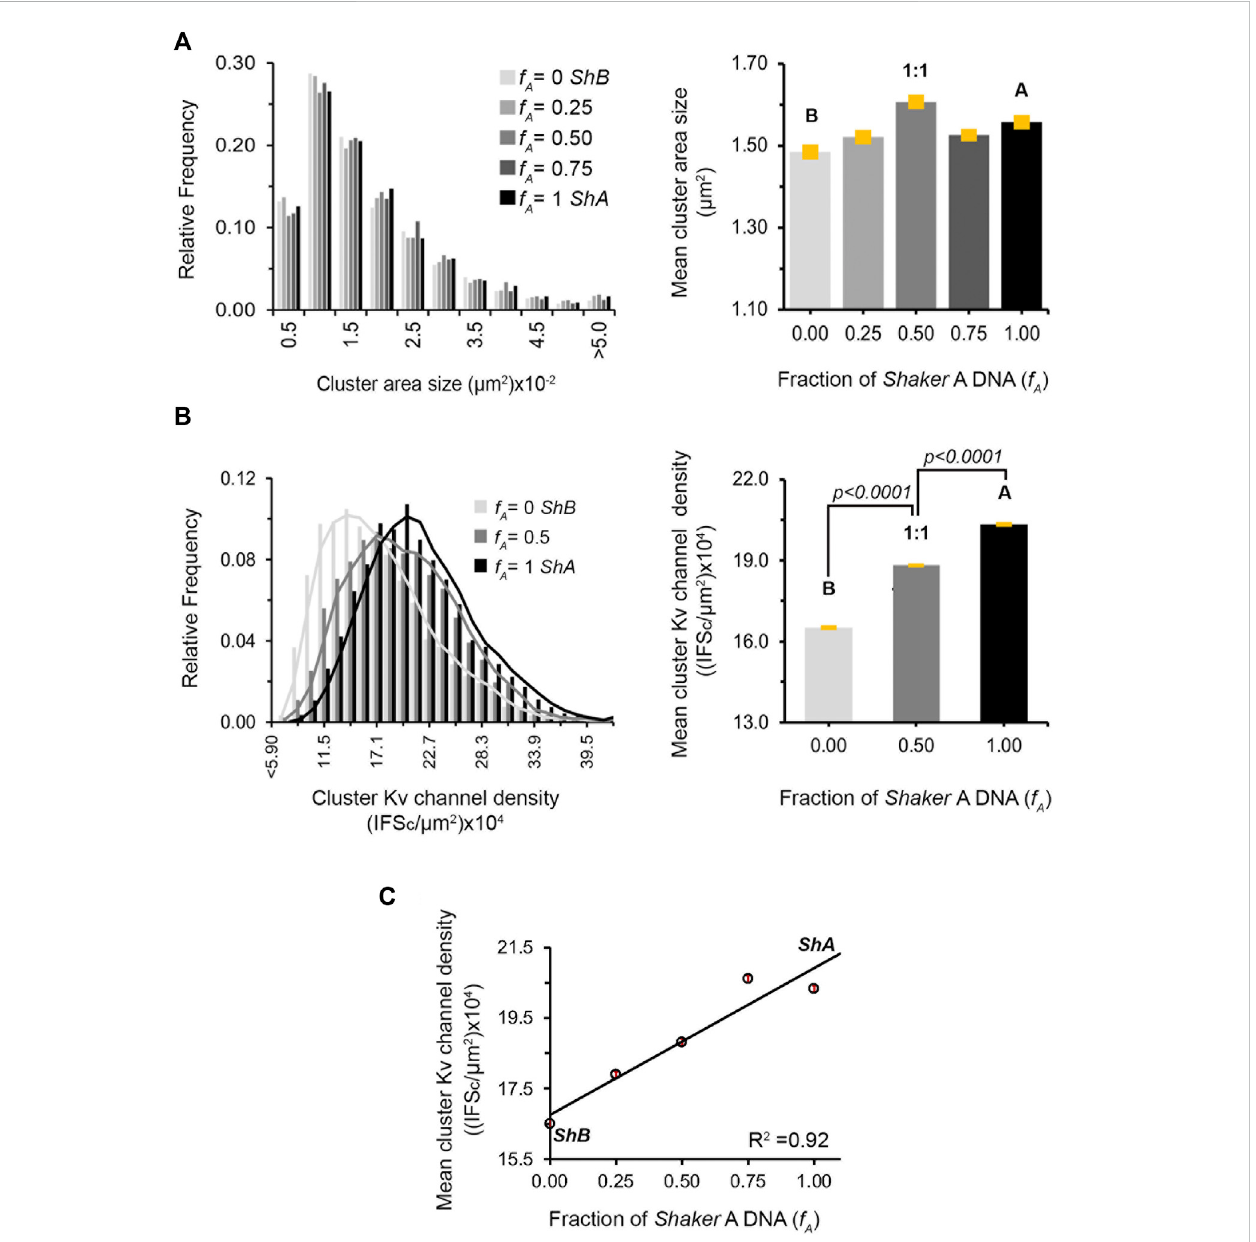
FIGURE 6 Regulation of clustering site Kv channel density by heterologous subunit assembly. (A) Cluster Kv channel area size distributions of cells transfected with different A : B subunit DNA concentration ratios, as evaluated by clustering analysis and supported by PSD-95. Distributions in steps of 0.5 (x10 − 2 ) μ m 2 are presented ( n = 3000 – 5,000 clusters). Comparison of the mean values of cluster ion channel area size for the different A : B subunit ratio treatments is given in the right panel. Values were all found to be similar, based on ANOVA (the p values for all comparisons are higher than 0.1) (B) Cluster Kv channel density distributions of cells transfected with DNA encoding for the Shaker A or B channels alone or at the 1:1 A : B subunit DNA transfection ratio, as evaluated by cluster signal intensity and supported by PSD-95, are shown in the left panel. Distributions in steps of 2.8 (x10 4 ) IFSc/ μ m 2 are presented ( n = 3,000 – 5,000 clusters). Cluster Kv channel density distributions for all A : B subunit DNA transfection ratios are presented in Supplementary Figure S3. Comparison ofthemean values ofcluster ion channel density for thedifferent A , B subunittransfections ortheir 1:1 combinationareshown intheright panel. All differences were found to be statistically signi fi cant, based on ANOVA for multiple comparisons (the p values for all three comparisons are smaller than 0.0001). (C) Dependence of the mean value of PSD-95-mediated cluster Kv channel density on A : B subunit DNA transfection ratio. Differences in cluster ion channel density were all found (but for the 0.75 and 1 value pair) to be statistically signi fi cant, based on ANOVA ( n = ~3,000 – 5,000; p <